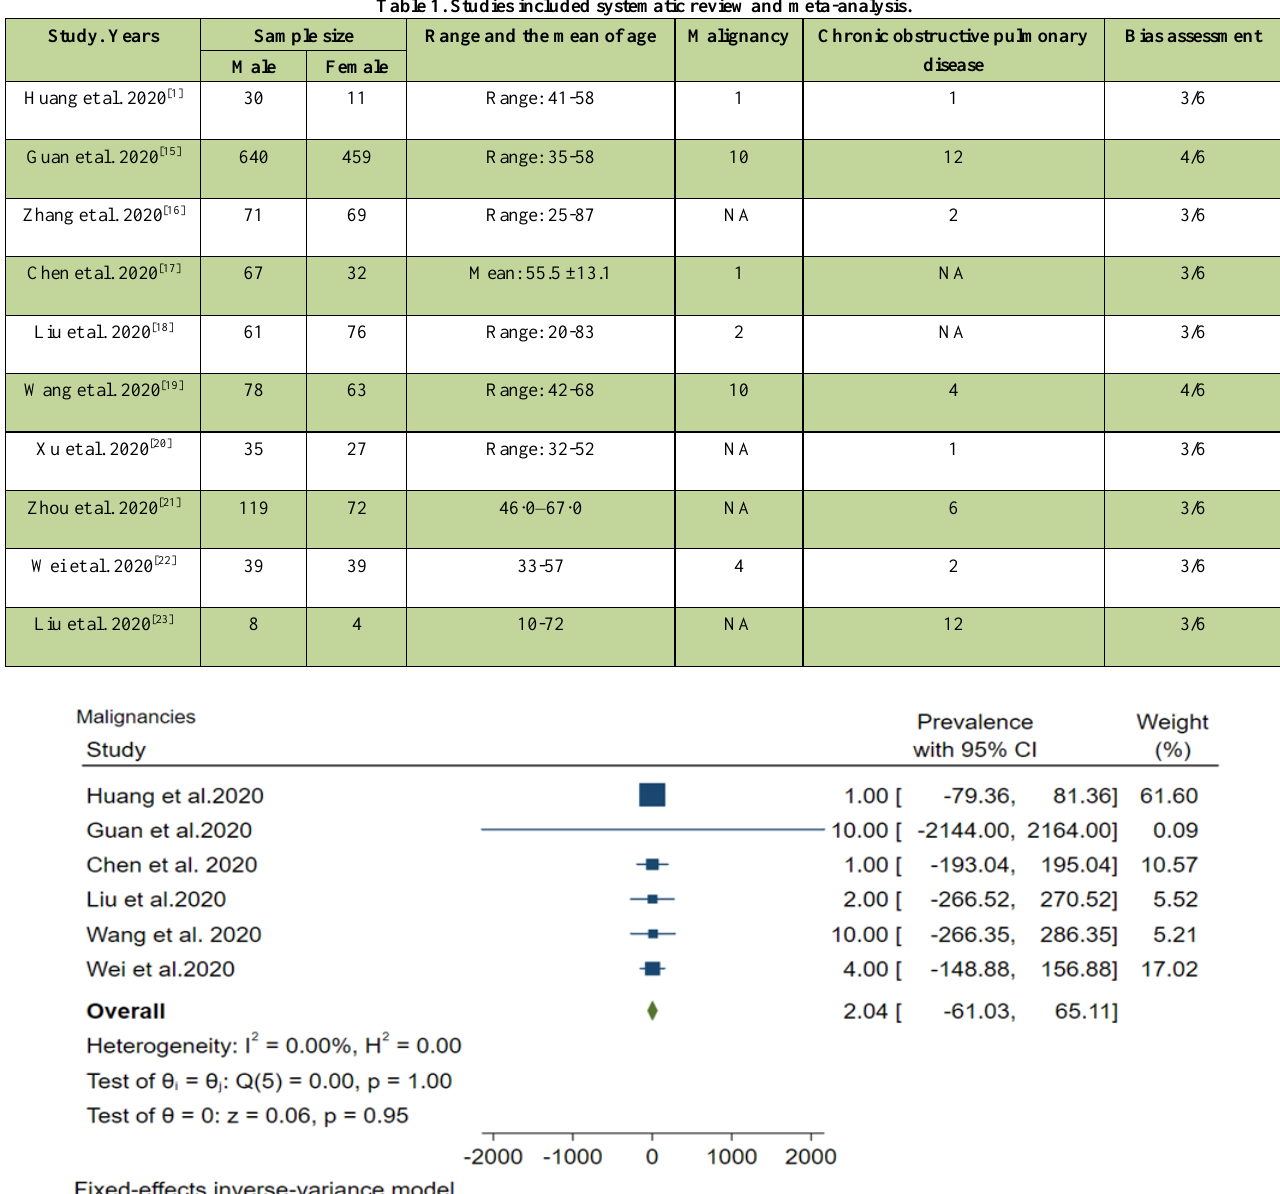
Figure 2. Forest plots showed the malignancy prevalence amongst COVID-19